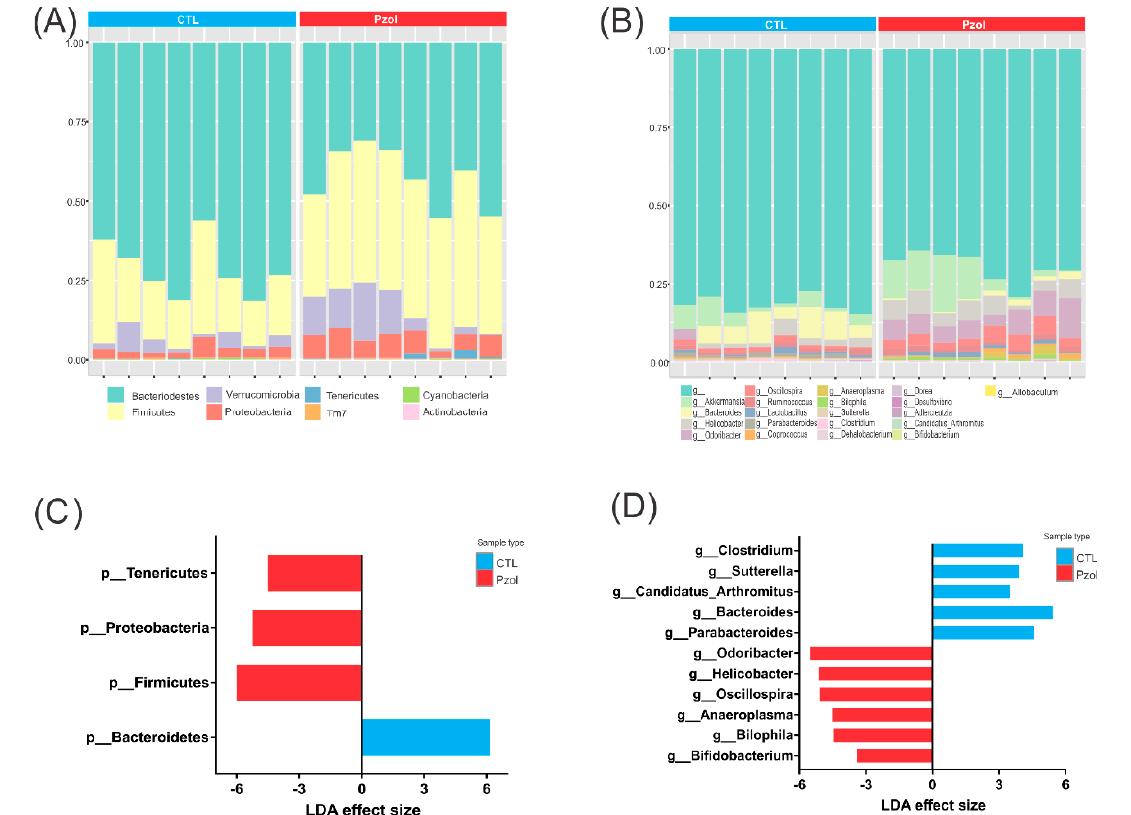
Figure 3. Taxonomic composition of community and LEfSe at phyla or genus level. Taxonomic composition of community through direct quantitative comparison of abundances of phyla ( A ) and genus ( B ) using stacked bar plot at individual sample level. LDA Effect Size (LEfSe) for phyla ( C ) and genus ( D ). LDA was used for biomarker discovery and explanation of high-dimensional metagenomic data. It incorporates statistical significance with biological consistency (effect size) estimation. The default was adjusted p -value cutoff = 0.05. ( n = 8 animals per group).